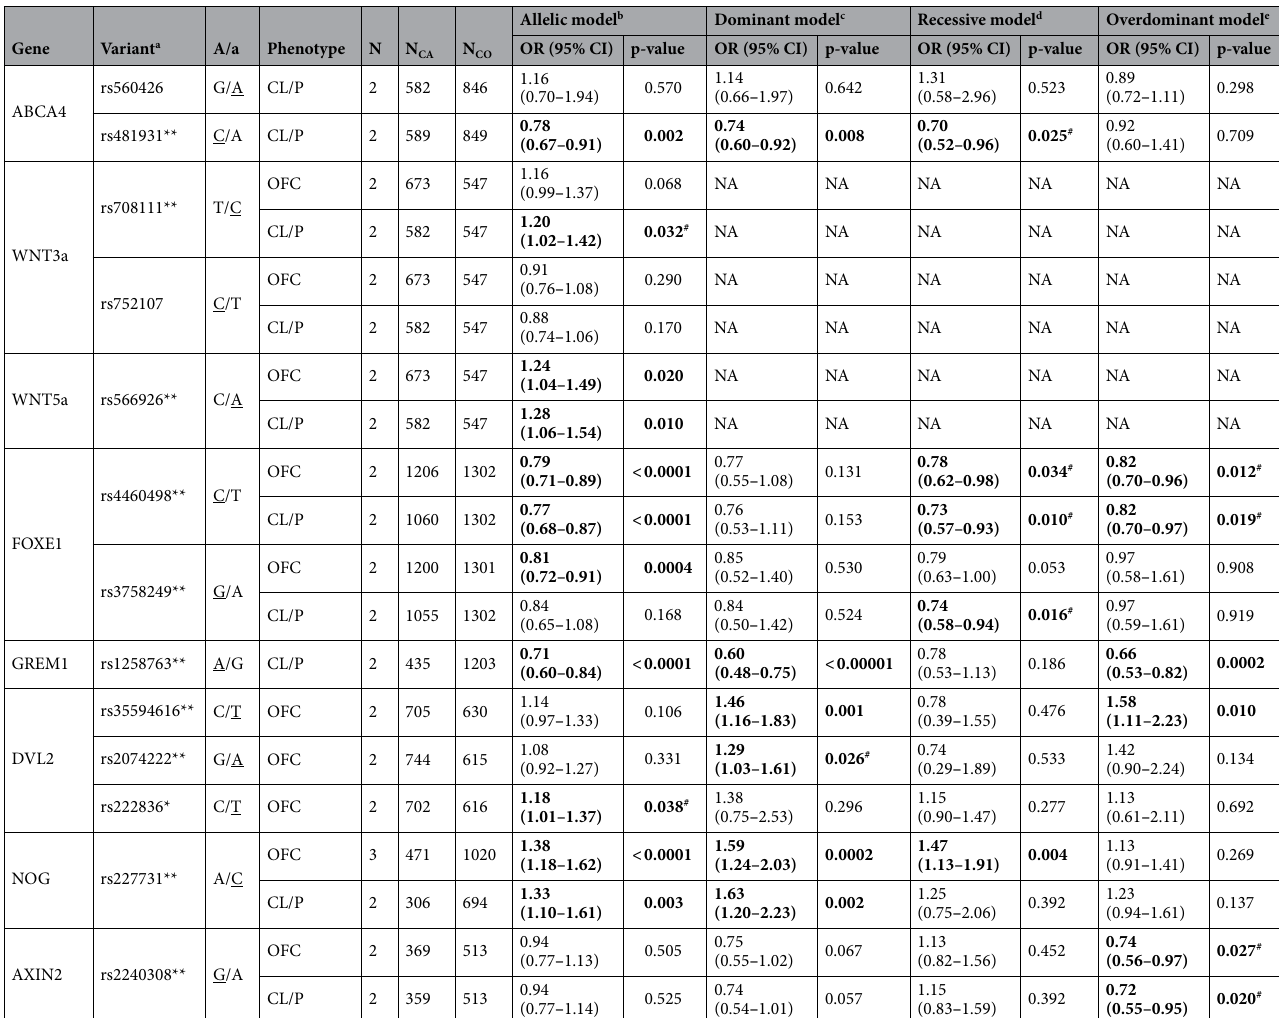
Table 2. Results of the meta-analysis performed to determine the associations between the genetic markers and the different non-syndromic orofacial cleft phenotypes in populations of European ancestry; results for the genes where there were significant associations with moderate effect sizes. A/a, major and minor alleles, where major allele is listed first and risk allele is underlined; Phenotype, non-syndromic orofacial cleft phenotype studied (CL/P, cleft lip with or without cleft palate; CPO, cleft palate only; OFC, all phenotypes combined); N, number of studies included in the analysis (allelic model); N CA , total number of cases included in the analysis (allelic model); N CO , total number of controls included in the analysis (allelic model); NA, not available; OR (95% CI), pooled odds ratio with 95% confidence interval for each analysis. Abbreviations of gene names are given in Supplementary Table S4 and further details about the meta-analysis are presented in Supplementary Table S6. *Significant results with moderate (**) and small (*) effect sizes; the largest values for the variant were considered, regardless of the phenotype studied or genetic model used. # Results that did not remain significant after applying Bonferroni correction. a Genetic variants found in named genes or in their close proximity; listed based on chromosomal location; b minor allele (a) vs. major allele (A); c Aa + aa vs. AA; d aa vs. Aa + AA; e Aa vs. AA + aa. Statistically significant results are in